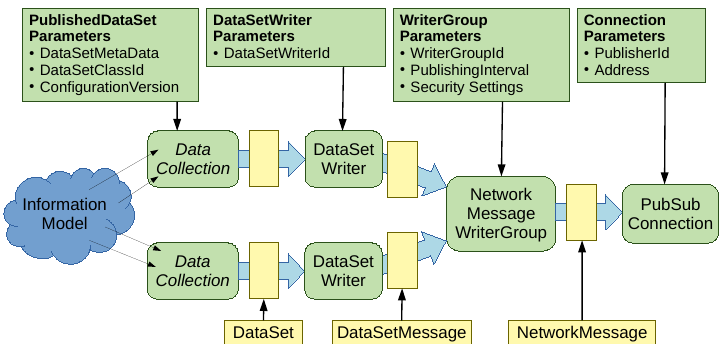
Figure 12. PubSub publishing sequence including configuration parameters (derived from OPC UA Part 14 [26] (Figure